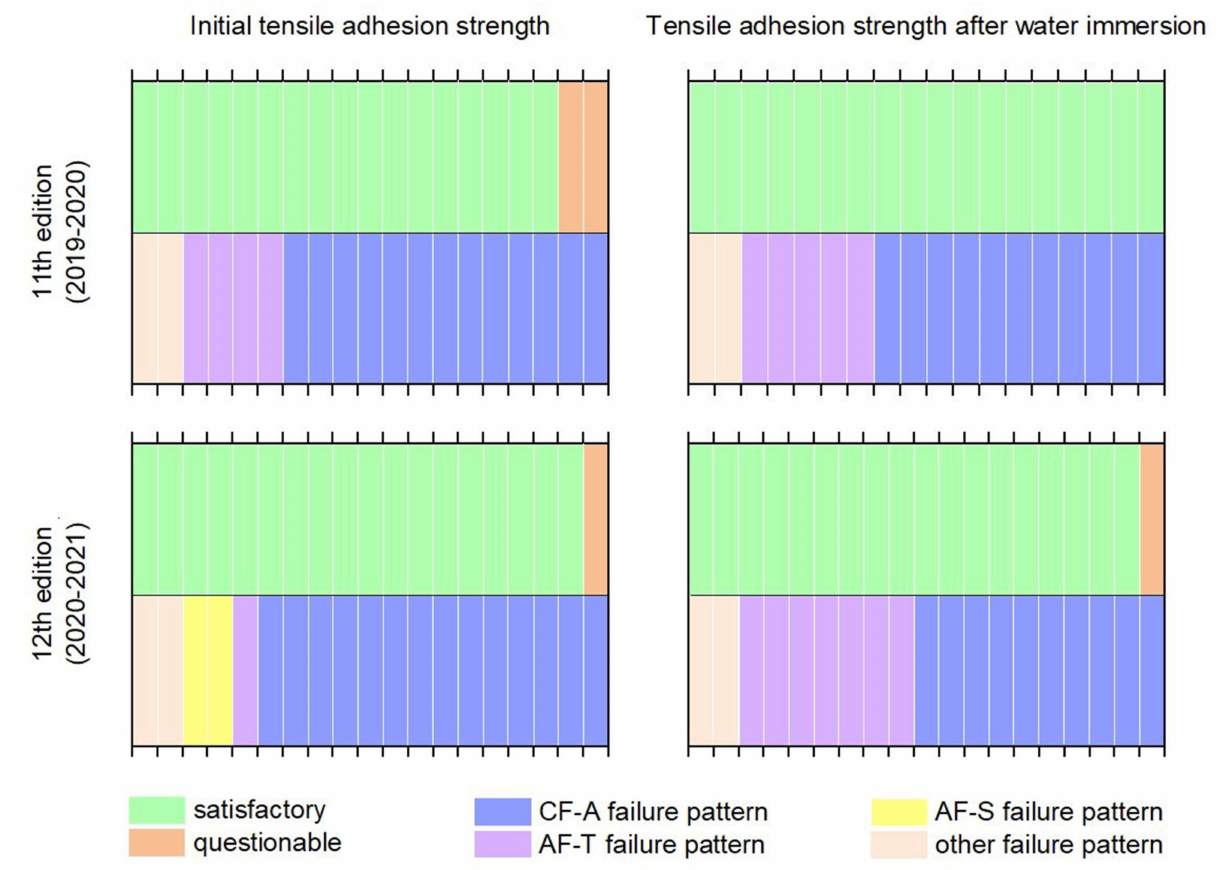
Figure 3. Summary of the results of the CTA measurements in two editions of the